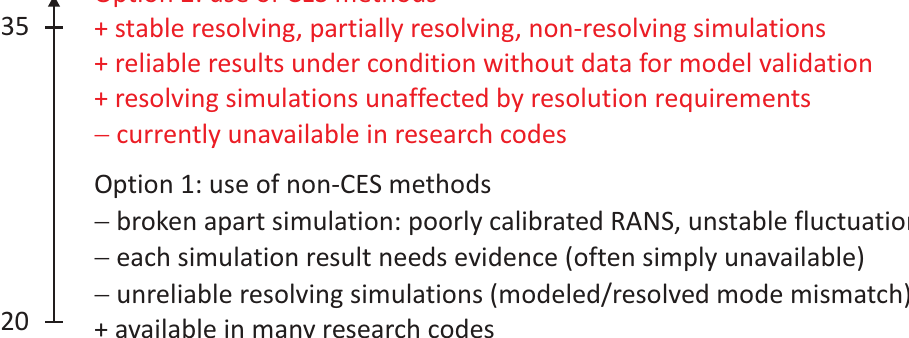
Figure 2. In extension of Figure 1, an illustration of options regarding the future use of hybrid RANS-LES methods including characteristic advantages (+) and disadvantages ( −